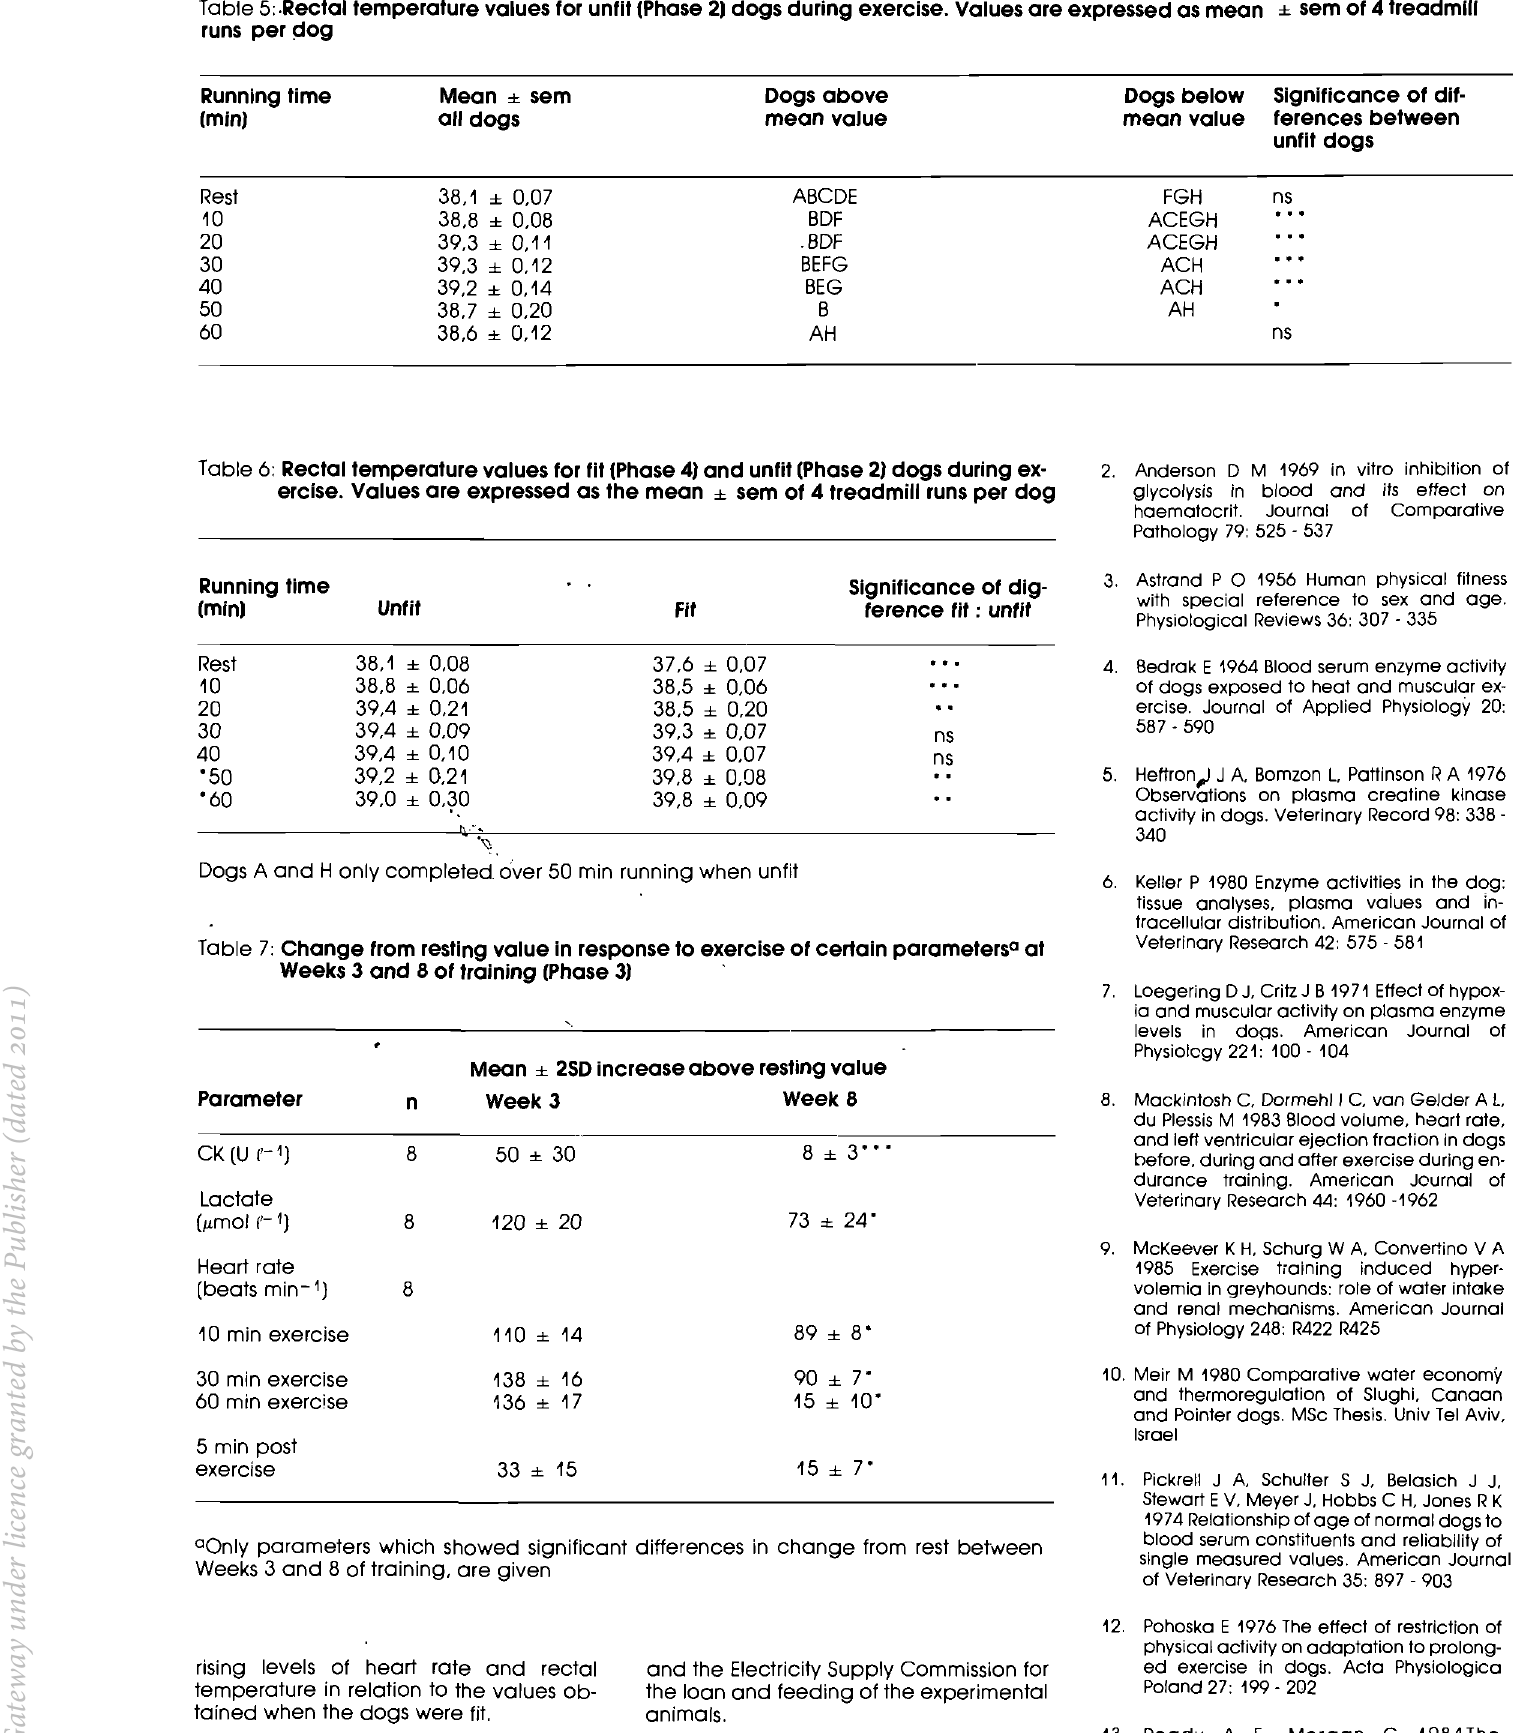
Table 5:.Rectal temperature values for unfit (Phase 2) dogs during exercise. Values are expressed as mean ± sem of 4 treadmill runs per !=log